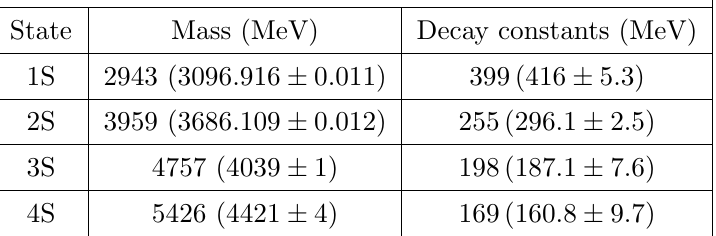
Table 2 . Holographic masses and decay constants for the charmonium S -wave resonances. Exper- imental values inside parentheses for